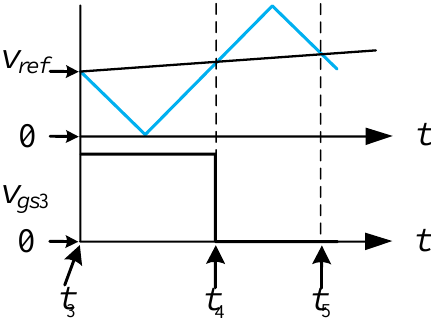
Figure 6. Gate signal of S 3 .